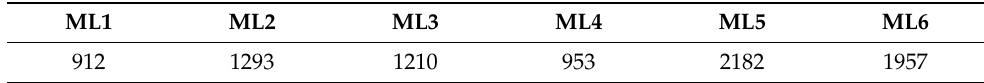
Table 11. Mooring line fatigue life